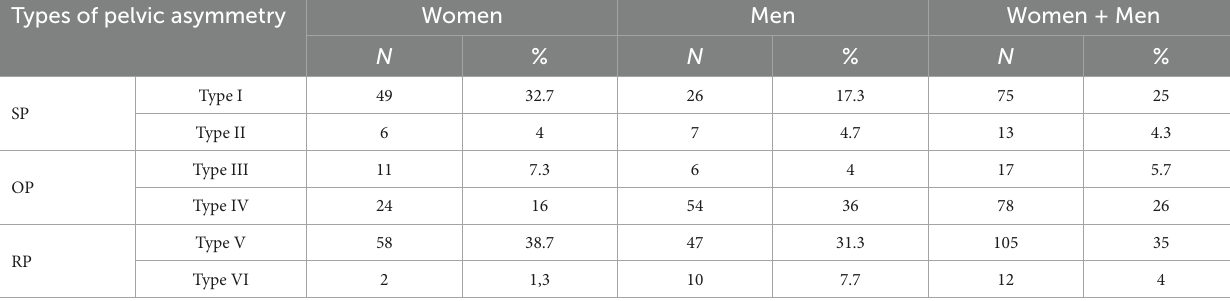
TABLE 5 Differences in frequency of occurrence of pelvic girdle asymmetry types depending on gender. Types of pelvic asymmetry